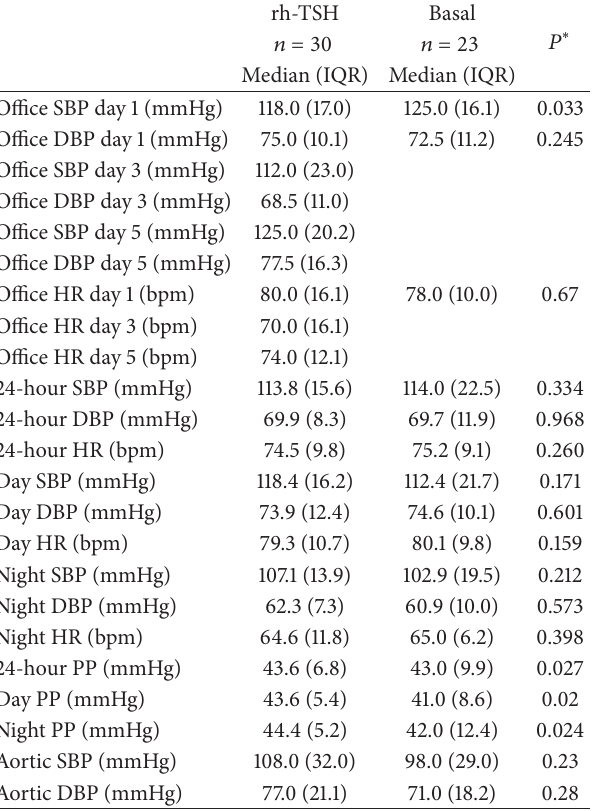
Table 1: Blood pressure parameters of DTC patients undergoing rhTSH stimulation test and basal measurements (the same subjects 1–4 weeks